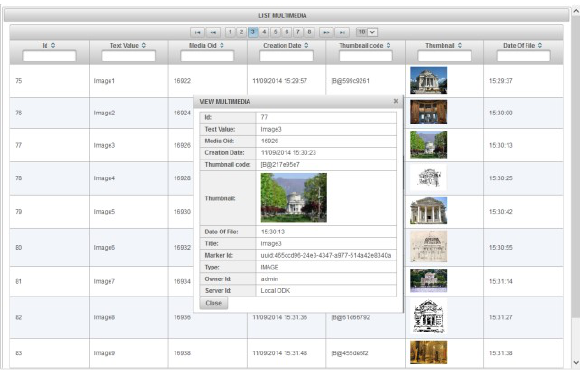
Figure 10. Web-application for remote data